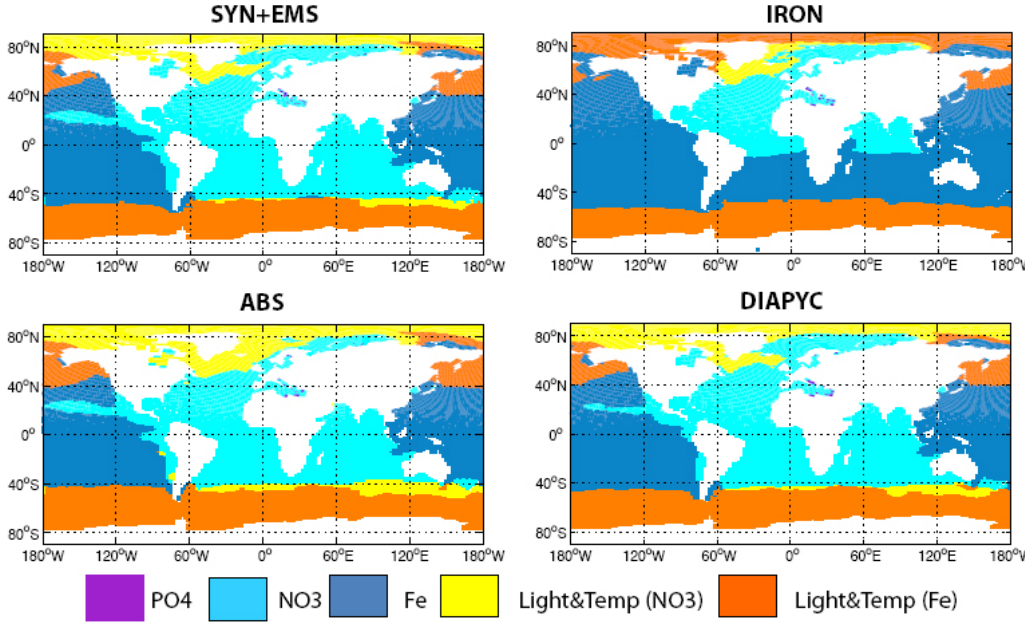
Fig. 21. Maps of factors limiting phytoplankton growth in the reference simulation and the sensitivity studies for a 2003–2007 mean. For nutrients the most limiting nutrient is shown, while for areas where light and temperature are limiting biological production, i.e., the value of the Michaelis-Menten term is above 0.7 (see Schneider et al., 2008 and explanations in the text) both this limitation and the limiting nutrient (in brackets) are